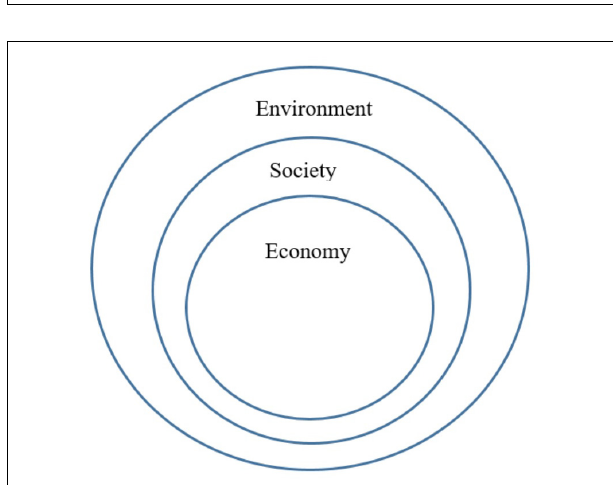
FIGURE 2 | Nested sustainable development – the economy is dependent on society and both dependent on the environment. Source: Giddings et al. (2002, p.